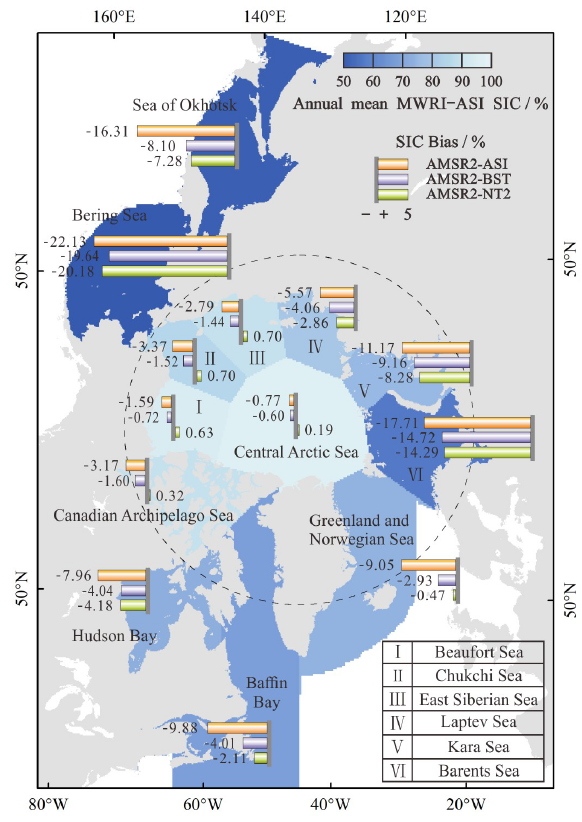
Figure 3. Annual mean MWRI-ASI SIC (The color code gives the SIC between 50 and 100%). Biases (The left is negative, and the right is positive) between AMSR2-ASI (orange), AMSR2- BST (purple), AMSR2-NT2 (green) and MWRI-ASI SIC in Arctic sea area in 2018. The dash line indicates the Arctic